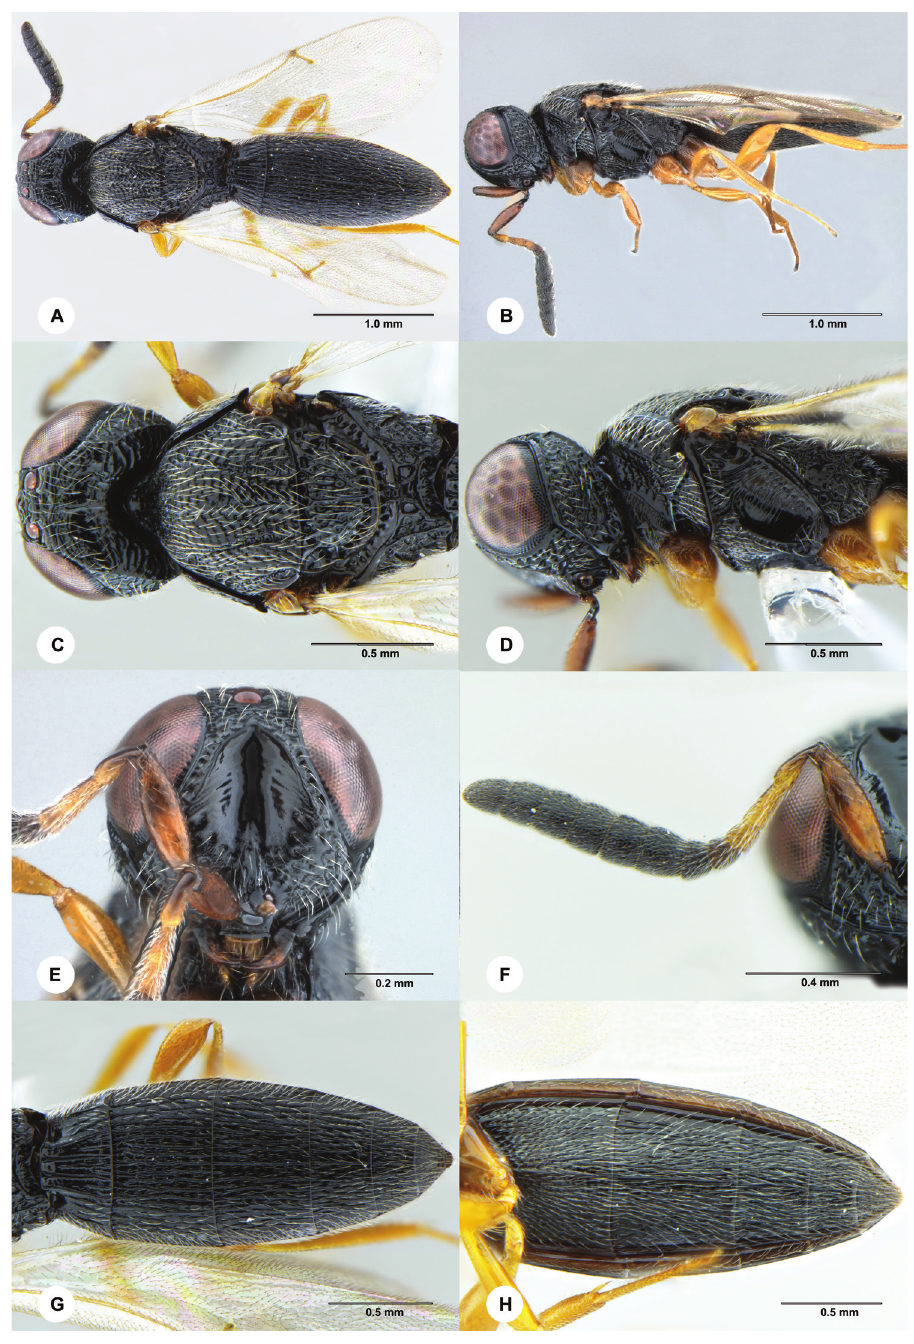
Figure 5. Oxyscelio stenos Mo & Chen, sp. nov., holotype, female (SCAU 3049080) A dorsal habitus B lateral habitus C head and mesosoma, dorsal view D head and mesosoma, lateral view E head, anterior view F antenna G metasoma, dorsal view H metasoma, ventral